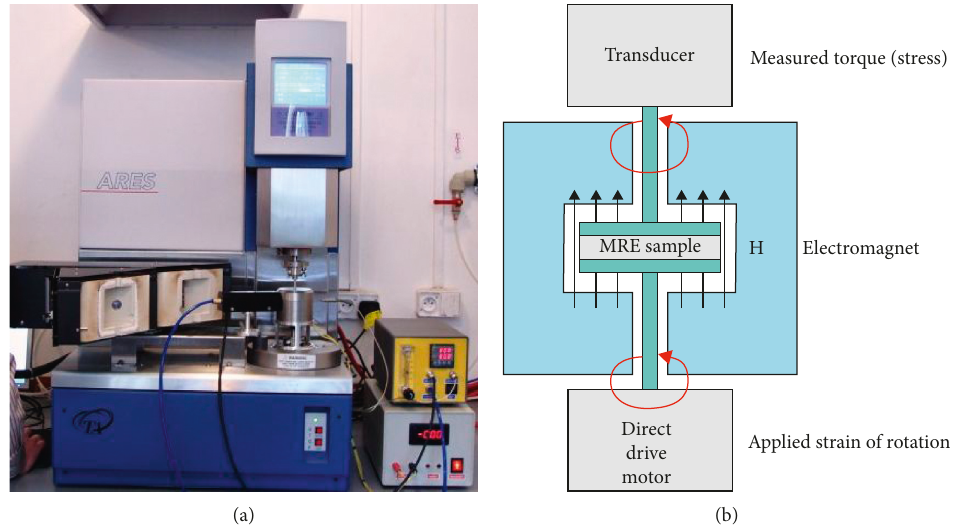
Figure 1: ARES rheometer with magnetic coil device and measurement